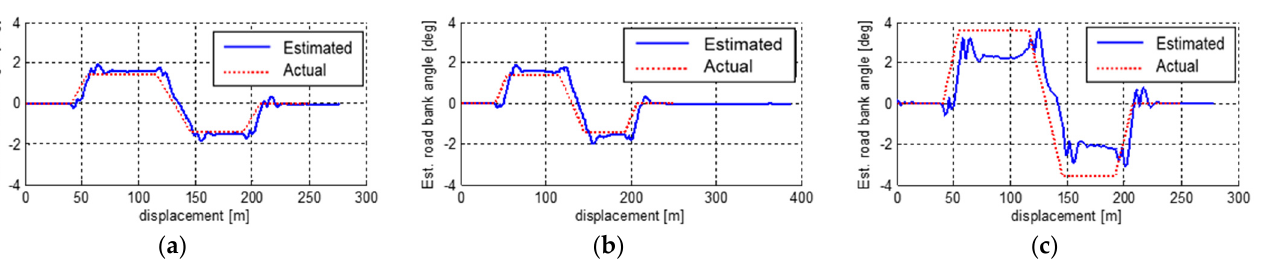
Figure 6. Estimated LTR using lateral acceleration and actual LTR in banked road condition. ( a , b ) refer to the straight road with the bank angle condition, and ( c ) refers to the S-curve with the road bank angle condition.